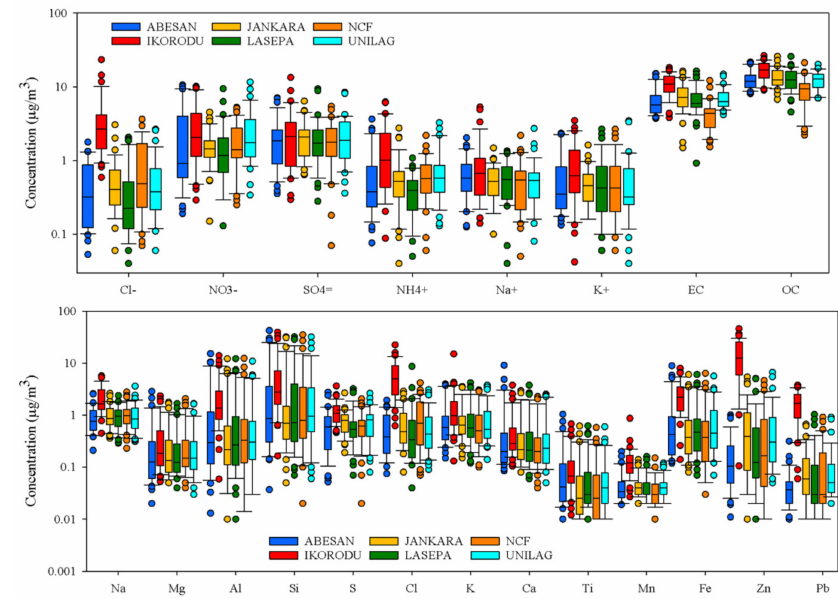
Figure 9. Average plots of abundance of various PM 2.5 species in 24 h filter samples from this study. ( Top ) Selected primary ionic (ion chromatograph assayed) species and secondary species with relatively high concentrations. ( Bottom ) Abundance of elements found in samples from X-ray fluorescence analysis.